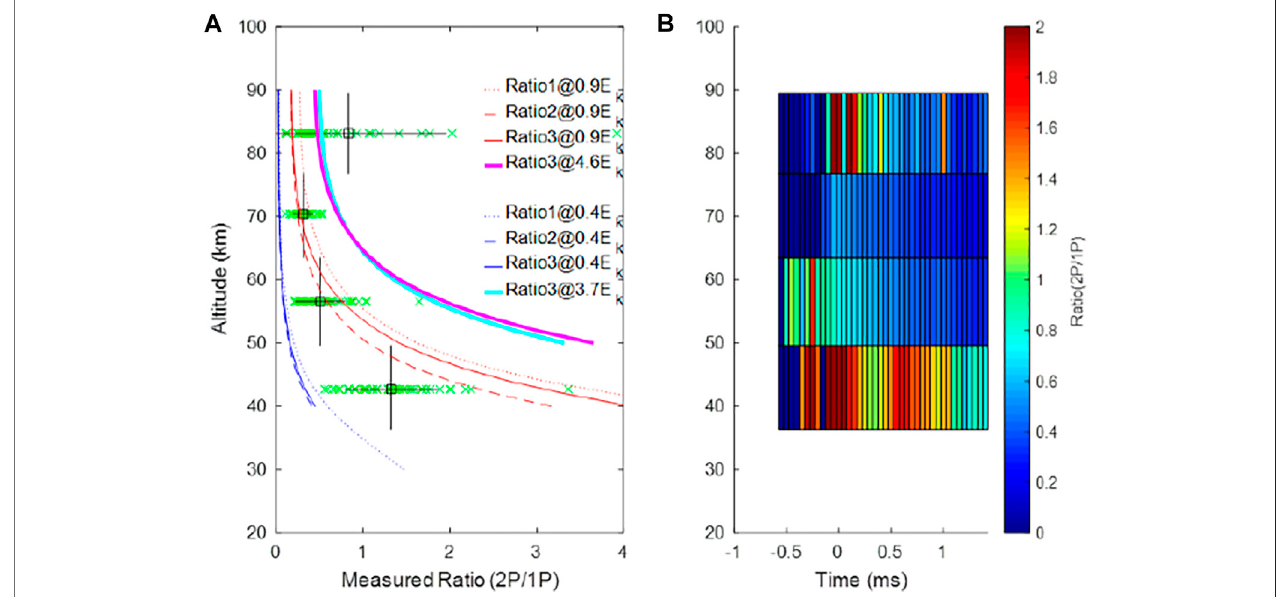
FIGURE 11 | The (A) the AP-measured ratio 2P/1P with predicted emission ratios and (B) the diagram of AP-measured ratios indicated by colors in altitude and time for the later-occurring sprite event at 22:01:23.178 (UT) from August 3, 2007.